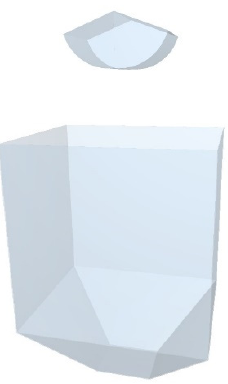
Figure 2. Cuboid hopper and grab model.